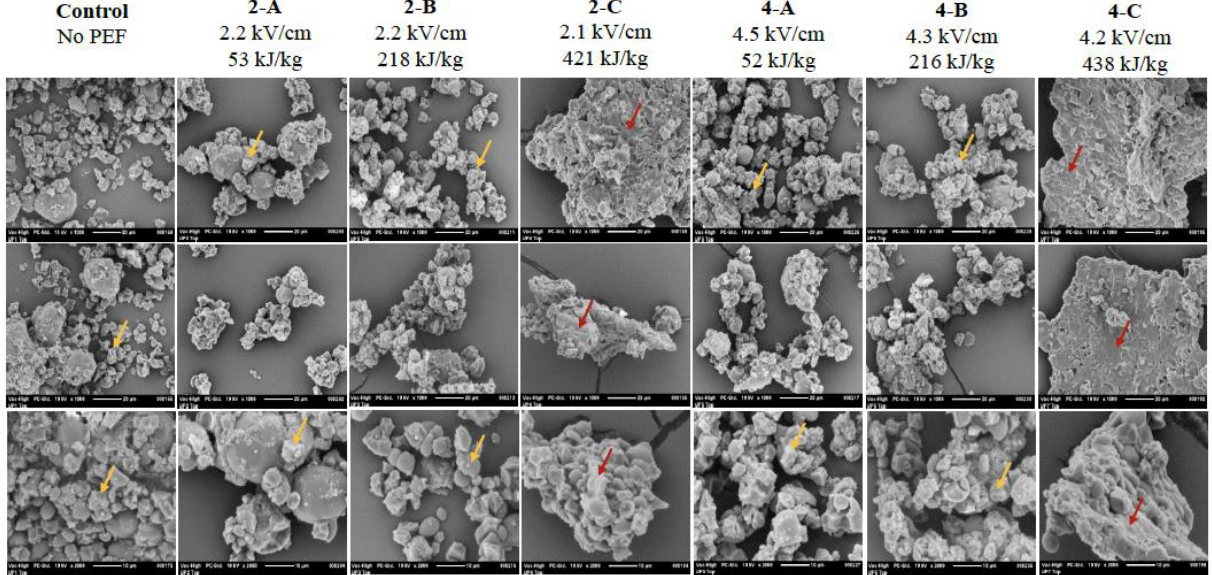
Figure 4. Scanning electron micrographs of Solid Segment (SS1) from PEF-treated oat flour. SEM images are presented at 1000× (rows 1 and 2) and 2000× (row 3) magnifications. Yellow and red arrows point to intact and damaged starch granules, respectively.